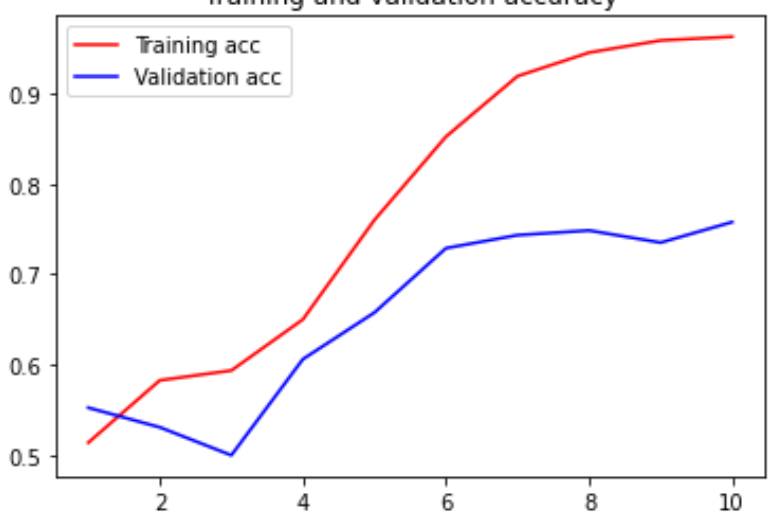
Figure 12. Training and validation accuracy for BoW to